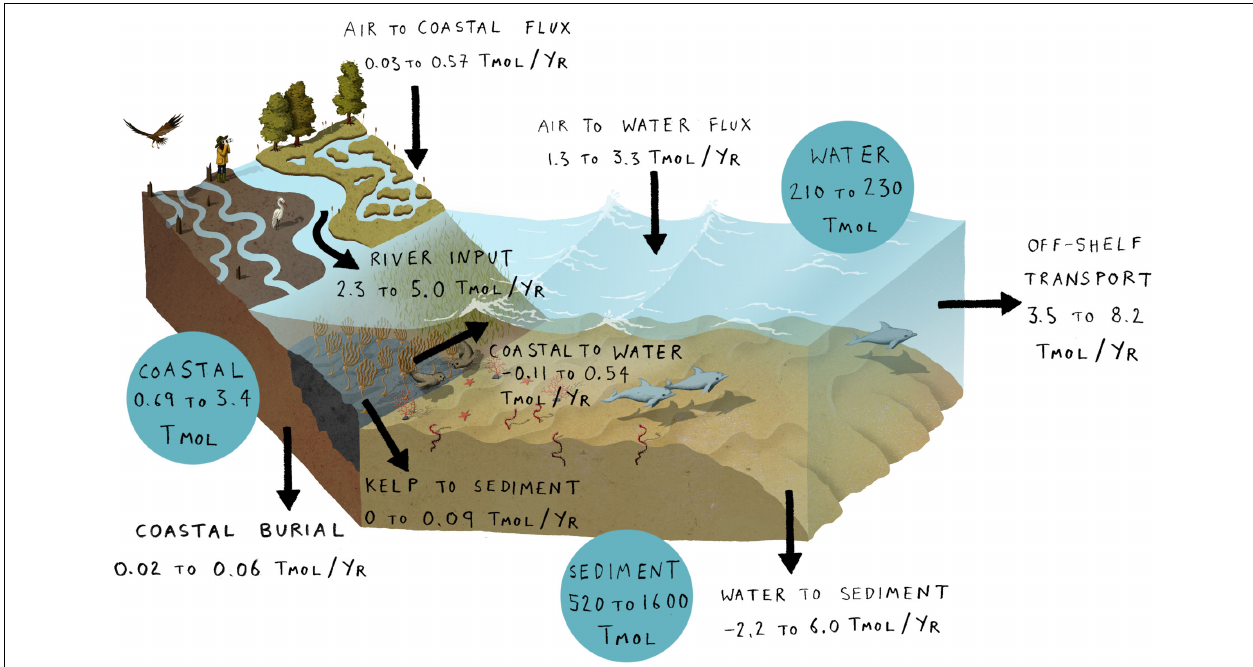
FIGURE 2 | A summary of the carbon budget of the north west European shelf. Stocks (blue) are given in units of Tmol (10 12 moles of carbon) and flows (black arrows) are given in units of Tmol year - 1 . Ranges are based on a synthesis of literature values ( Supplementary Material Part A